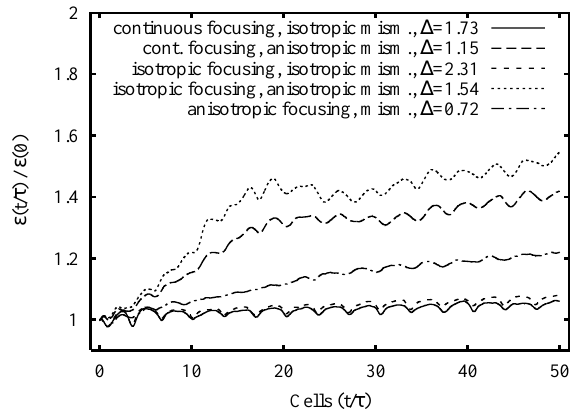
FIG. 5. Emittance growth factors ´ (cid:2) t (cid:1) t (cid:3)(cid:1) ´ (cid:2) 0 (cid:3) for 5000 simu- lation particles versus the number of cells obtained by 3D simulations of different focusing systems and matching con- ditions at s 0 (cid:1) 60 ± , s (cid:1) 15 ± per